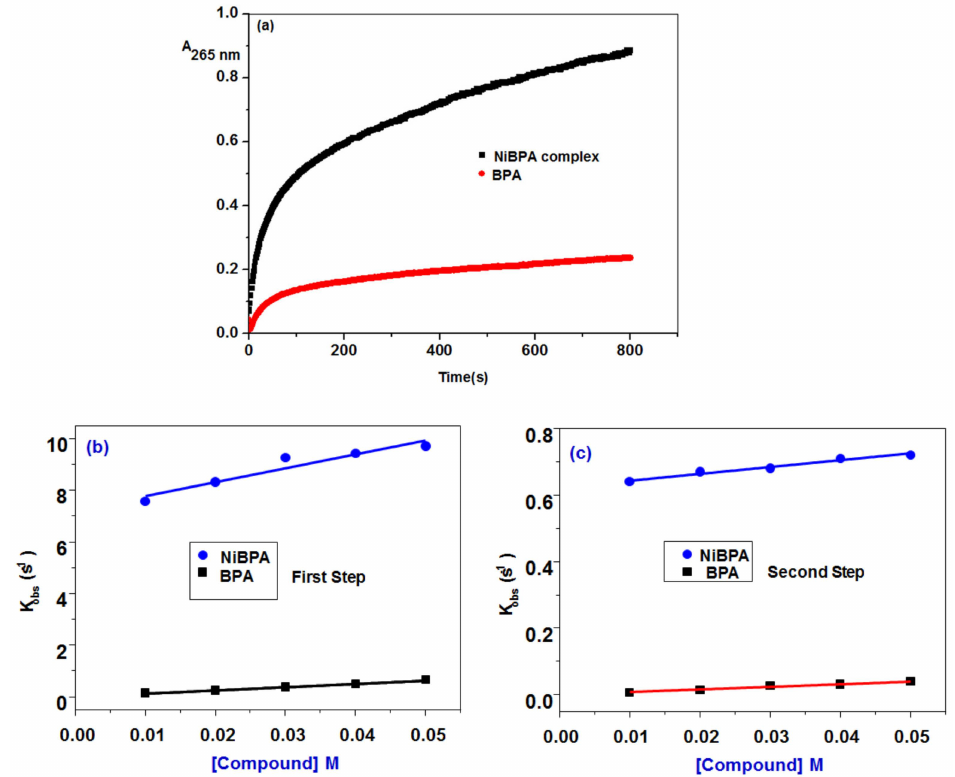
Figure 8. ( a ) Kinetic traces of BPA and NiBPA with BSA; variation of k obs vs. [ BPA ] and [ NiBPA ] for ( b ) the first and ( c ) the second interaction steps to